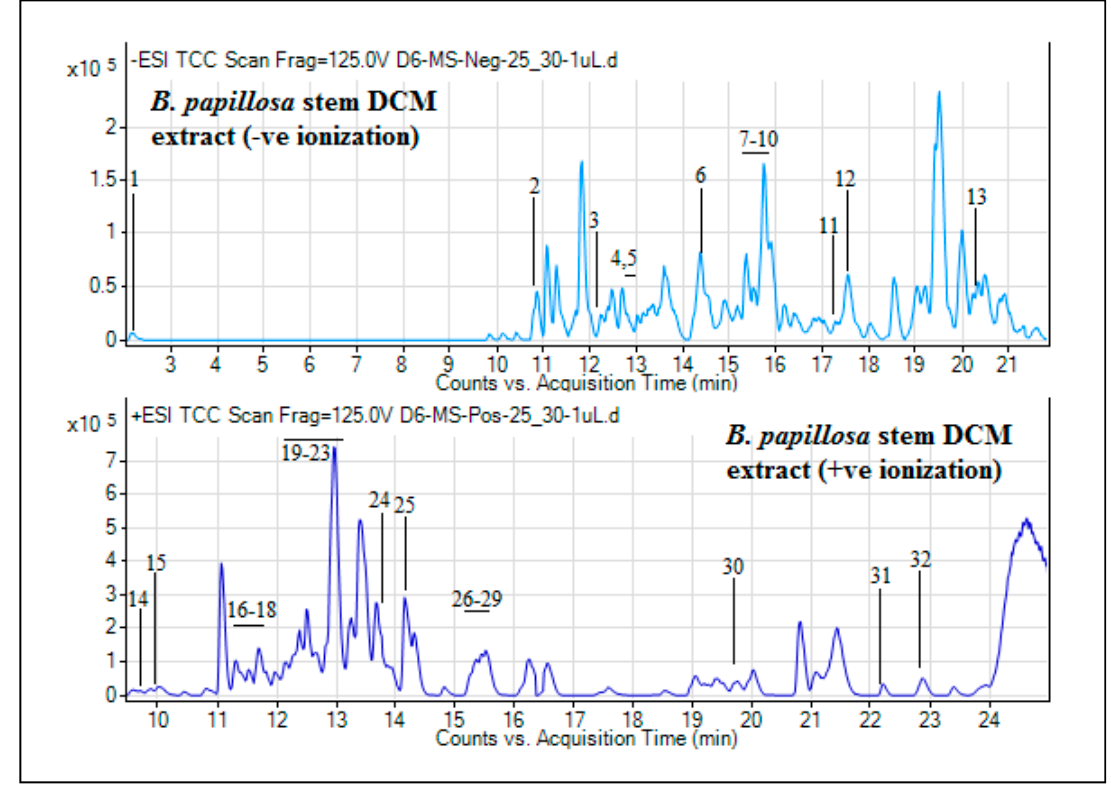
Figure 3. UHPLC-MS total ion chromatograms (TICs) of DCM extract of B. papillosa stem Table 4. Enzyme inhibition potential of aerial and stem extracts of B. papillosa .